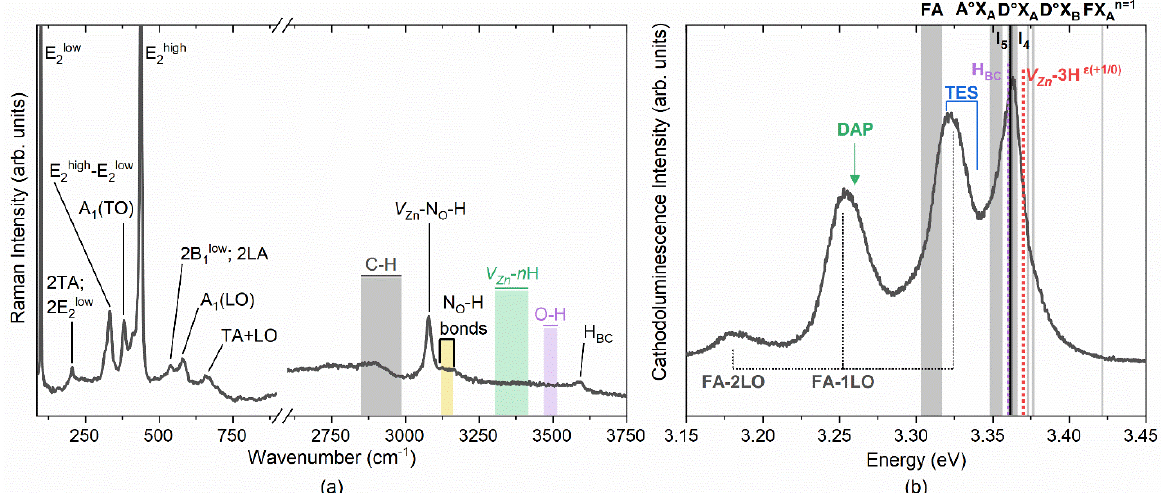
Figure 3. ( a ) Raman spectrum acquired on an array of undoped ZnO MRs grown by CBD and annealed for 3 h at 300 °C under oxygen atmosphere. The insets delimit the calculated and experimental vibrational frequencies from Raman and infrared absorption spectroscopy as deduced from Refs. [38,39,47,49,51–53]; ( b ) 5 K cathodoluminescence spectrum acquired on a single undoped ZnO MR grown by CBD and annealed for 3 h at 300 °C under oxygen atmosphere with a special emphasis on the NBE emission region. The insets represent the emission energy of optical transitions as deduced from DFT calculations and from experimental data in Refs. [38,39,54,55].